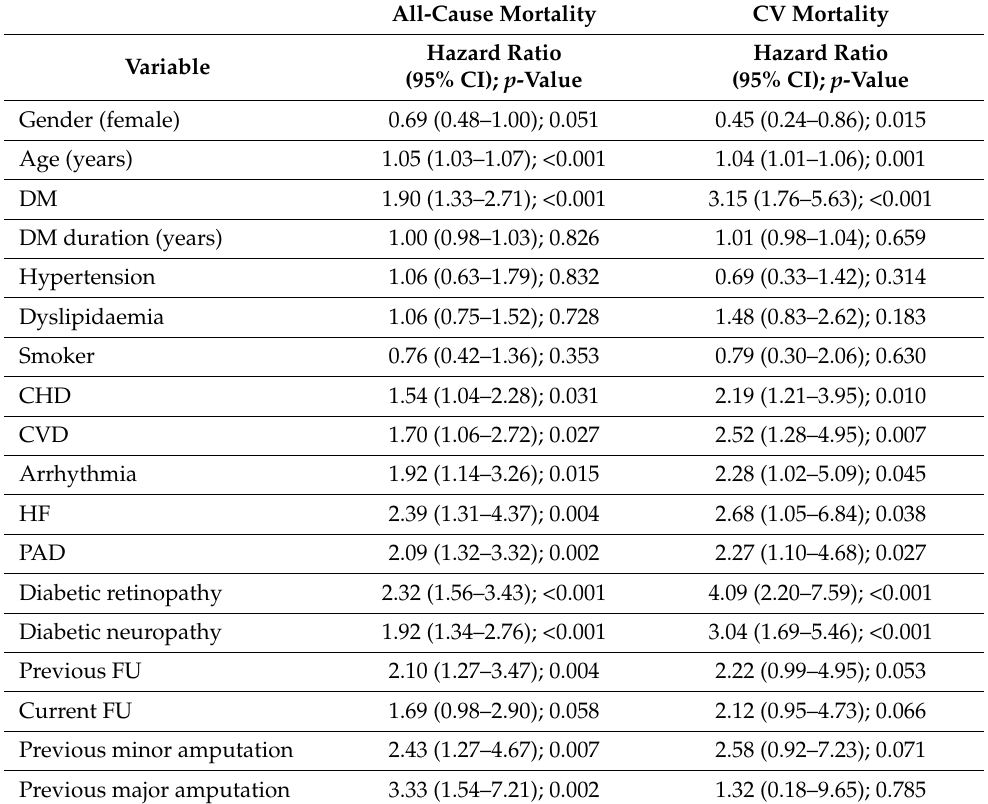
Table 2. Predictors of all-cause mortality and cardiovascular mortality in patients on haemodialysis ( n =